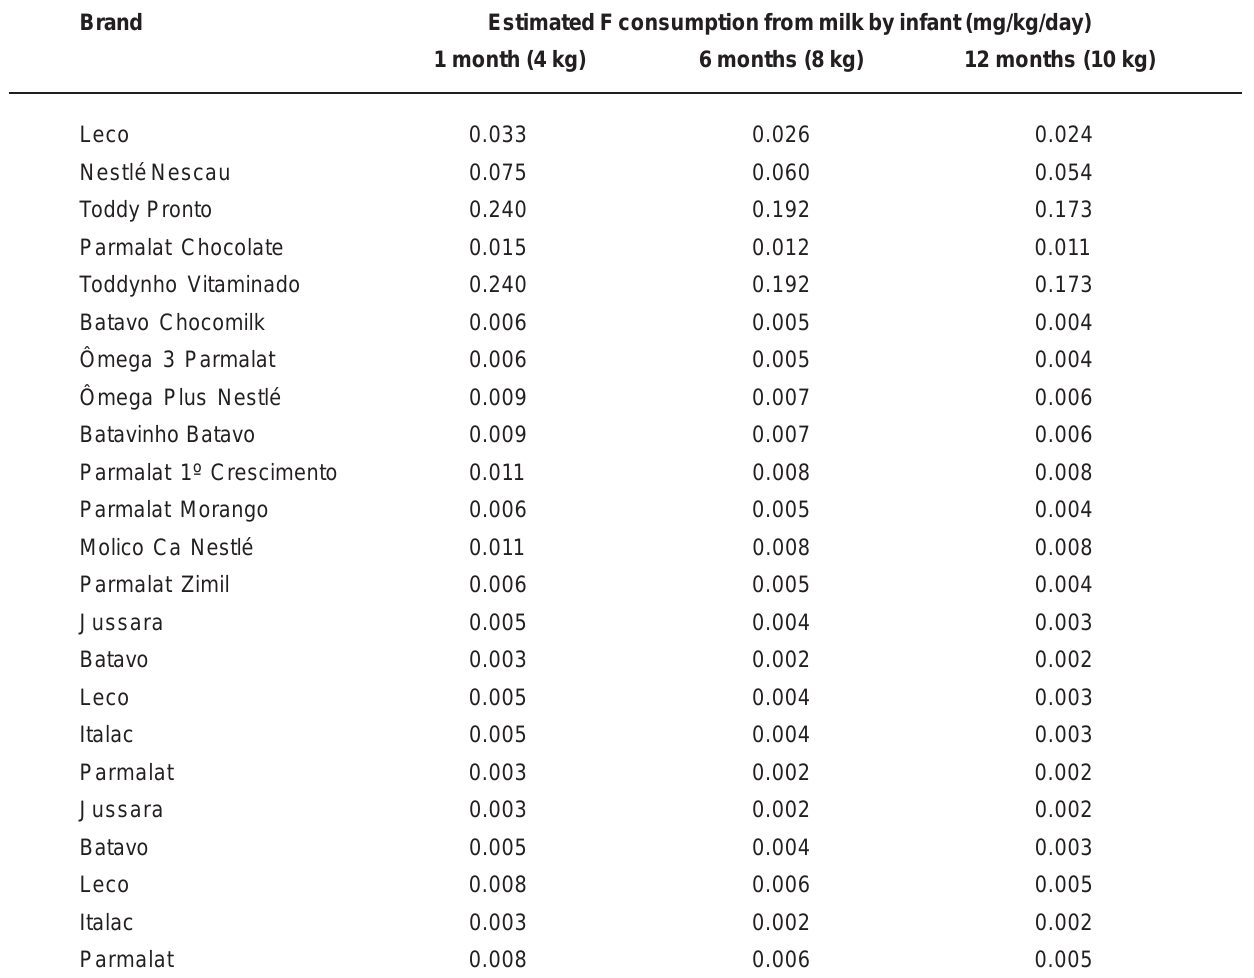
TABLE 3- Estimated fluoride intake from